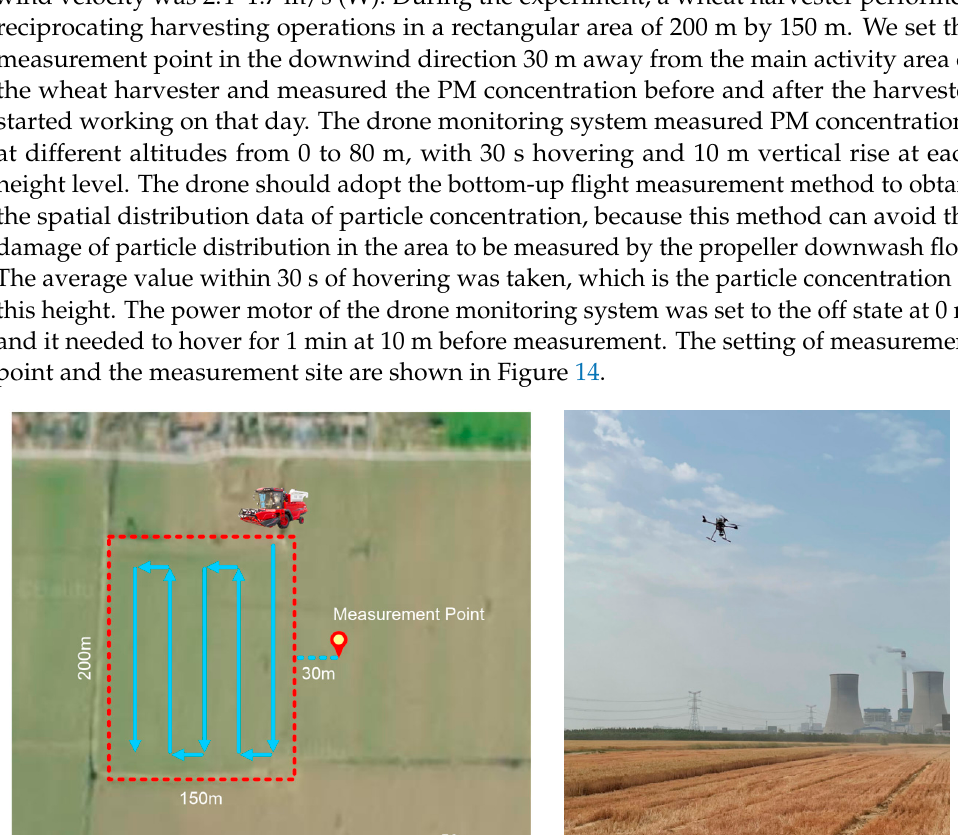
Figure 13. Locations of the experimental site for agri-environment measurement.